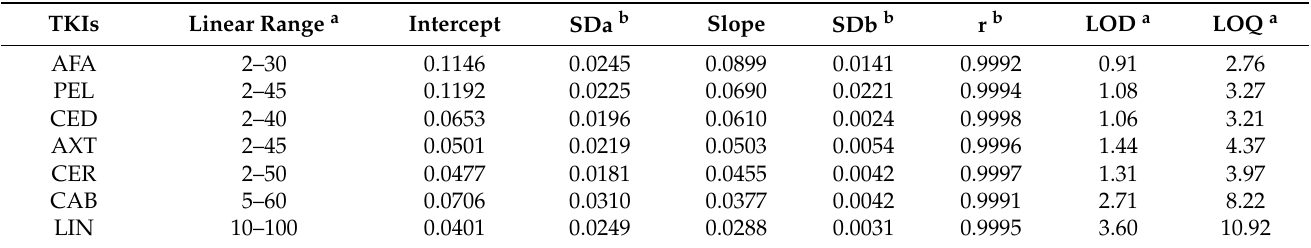
Figure 8. Calibration curves for the determination of TKIs by the proposed MW-SPA based on their reaction with iodine. Table 6. Calibration parameters for the analysis of TKIs by MW-SPA based on their CT reaction with iodine.